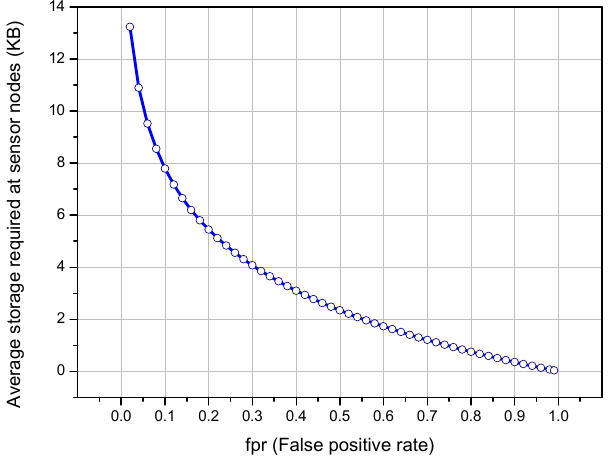
Figure 6. Size of m for representing current Snort signature-set with respect to